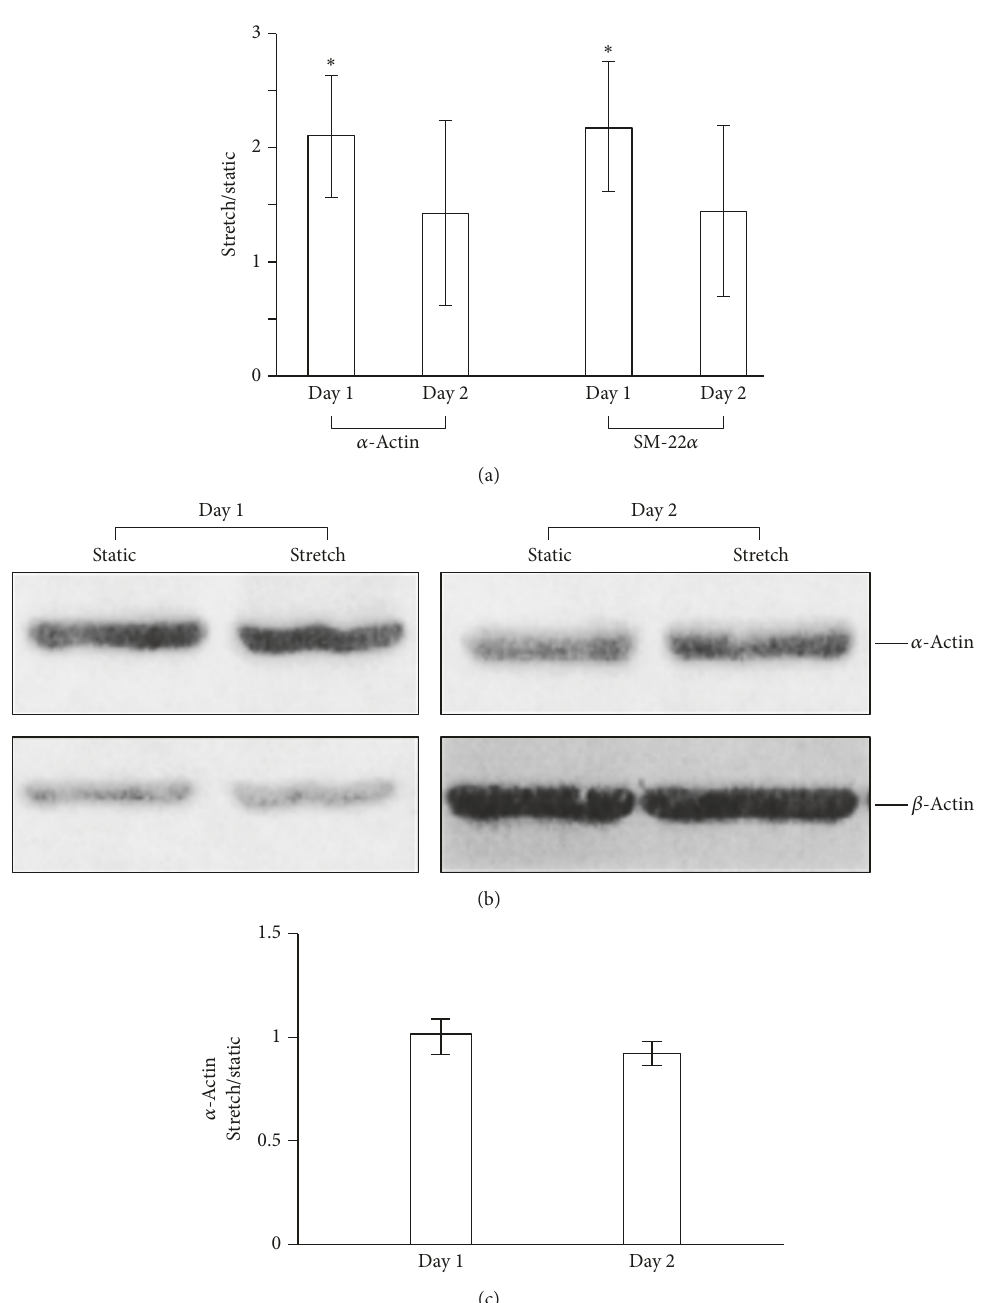
Figure 4: Effects of uniaxial strain on SM marker expression in MSCs. MSCs were cultured on collagen-coated elastic membranes for 1 day and subjected to 10% uniaxial strain at 1Hz or kept as static controls for 1 and 2 days. (a) The RNA from each sample was reverse-transcribed into cDNA and the gene expression of SM a-actin, SM-22a, and GAPDH was analyzed by qPCR with their respective primers. The expression level of each gene was normalized with the level of GAPDH in the same sample. The ratio of the gene expression (stretch/static) is presented as mean ( ± ) standard deviation from at least three experiments. ∗ Significant difference ( 𝑃 < 0.05 ) from 1. (b) The protein expression of SM a-actin and actin was analyzed by immunoblotting with respective antibody. (c) Statistical analysis of protein expression. The protein expression was quantified, and the expression level of a-actin was normalized with the level of h-actin in the same samples. The ratio of the normalized protein expression (stretch/static) is presented as mean ( ± ) standard deviation from at least three experiments. From Park et